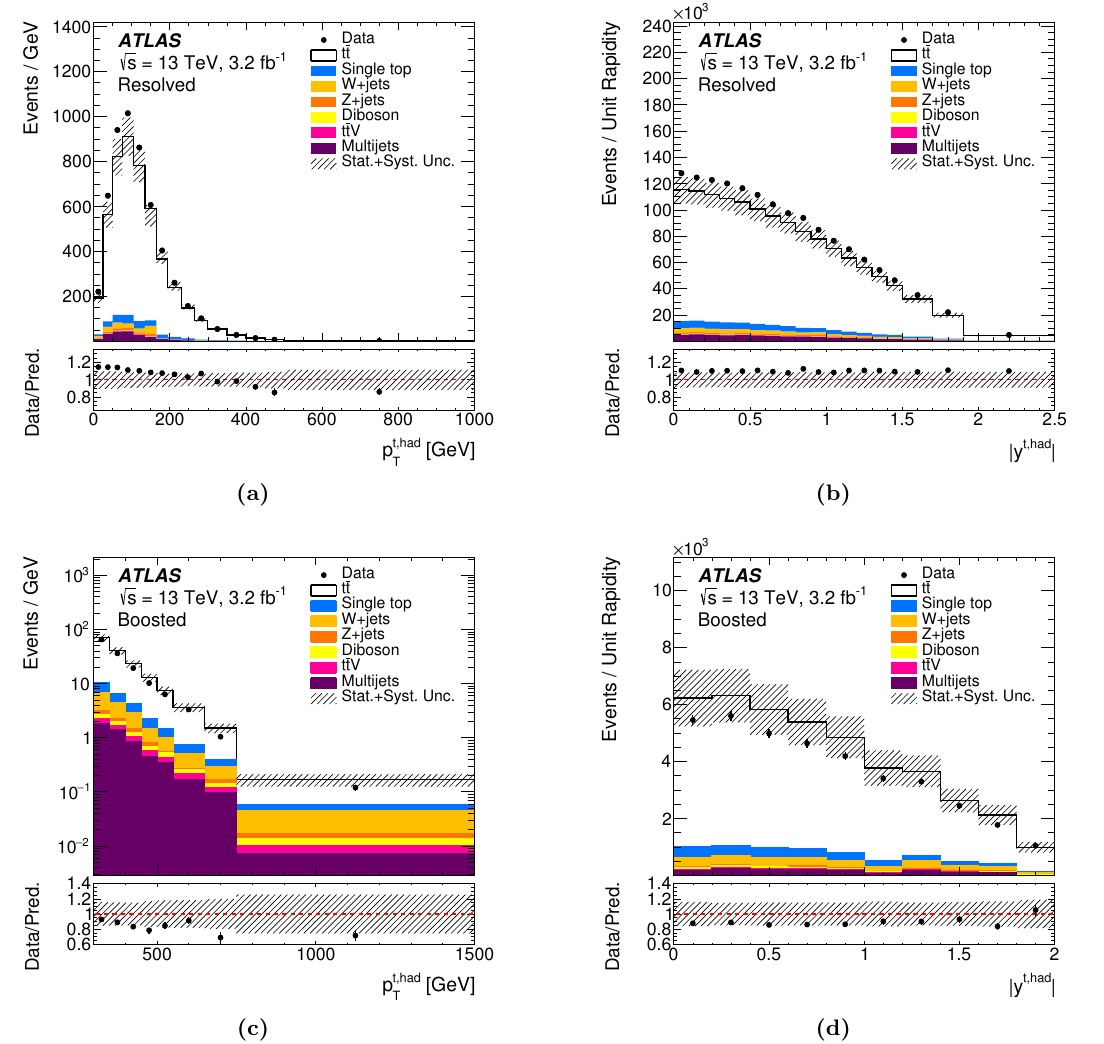
Figure 6. Distributions of observables in the combined ‘ +jets channel at detector level: (cid:12) (cid:12) (a) hadronic top-quark transverse momentum p t; had and (b) absolute value of the rapidity (cid:12) y t; had (cid:12) T in the resolved topology, and the same variables in the boosted topology (c), (d). Data distributions are compared to predictions, using Powheg + Pythia6 as the t (cid:22) t signal model. The hatched area indicates the combined statistical and systematic uncertainties (described in section 9) in the total prediction, excluding systematic uncertainties related to the modelling of the t (cid:22) t system.